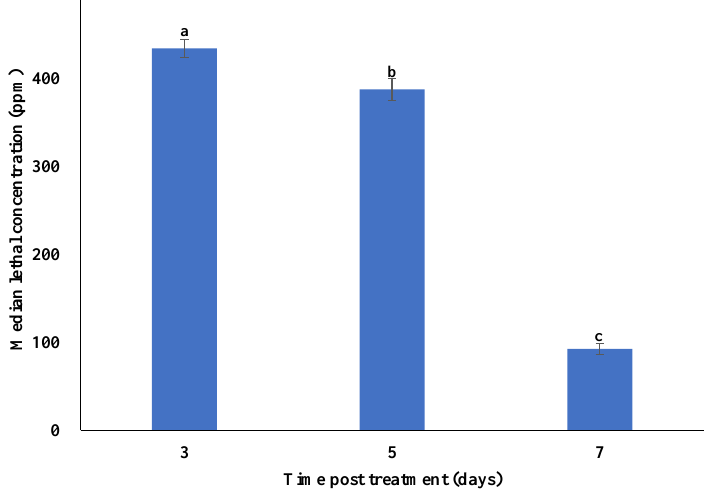
Figure 9. Median lethal concentrations (LC 50 ) of Metarhizium anisopliae – chitosan nanoparticles against P. xylostella under field conditions. Error bars indicate the standard error of the means based on three replicates. Bars with distinct letters at different days post treatment differed significantly from each other.